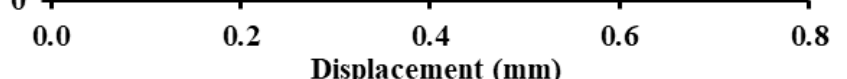
Figure 13. Quasi-static graph of adhesive bond ABFE1 with loading 5–70% (165–2307 N)—734 cycles.